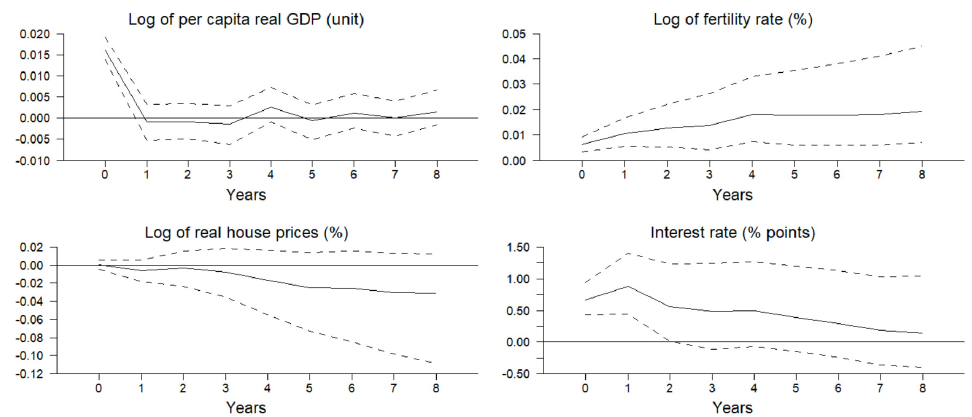
Figure 2. Responses to a per capita real GDP shock in the baseline SVAR.